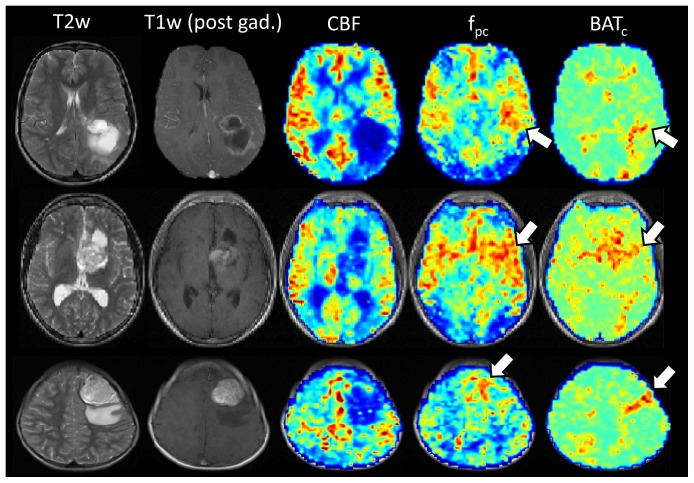
Examples of standard T2w and T1w (post contrast) images obtained in three brain tumor patients, with fitted values of cerebral blood flow (CBF), pre-capillary blood volume (fpc) and bolus arrival time at the capillary bed (BATc) overlaid.The top row shows data from a 10 year old male with a glioblastoma multiforme (WHO grade IV). The middle row shows data from a 15 year old male with a ganglioglioma (WHO grade I), and the bottom row is from a 7 year old female with an anaplastic ganglioglioma (WHO grade III). The white arrows highlight regions of increased fpc and BATc in the tumor region. Fitted parameter maps are shown after affine registration to the FLASH images acquired during the same imaging session.